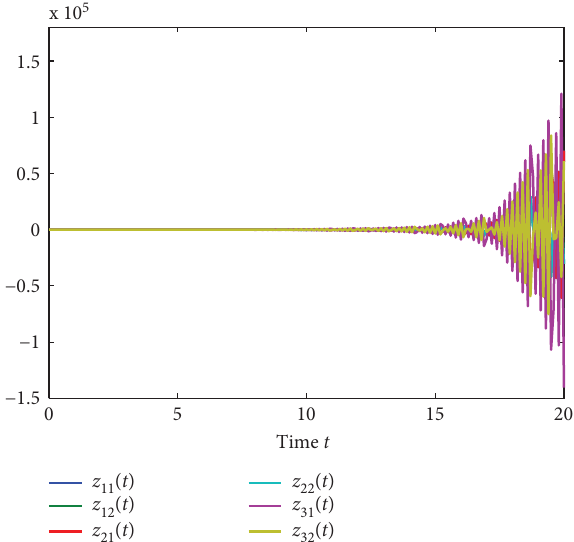
Figure 2: Trajectories of error system (5) without control